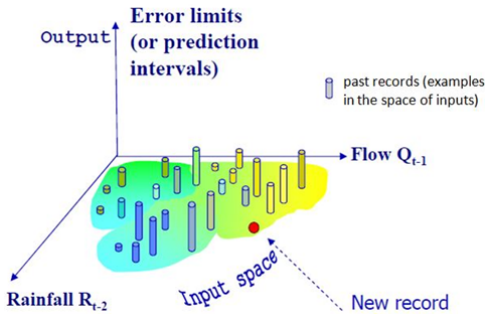
Figure 2. An example of fuzzy clustering of input data (the pre- dictors are past rainfall at lag t − 2 and past flow at lag t − 1) dur- ing training of the uncertainty model, U (adapted from Solomatine,